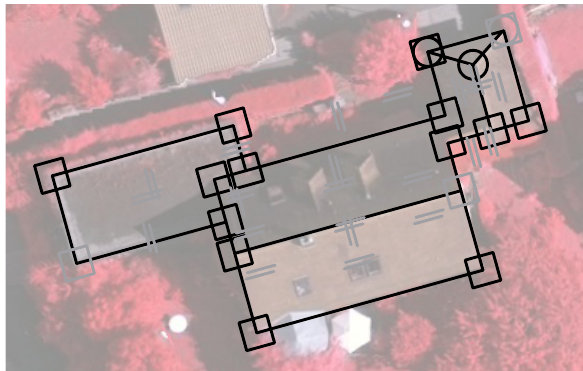
Figure 8. An acquisition of roof areas featuring orthogonality, parallelism, and concurrence. Redundant constraints are marked in gray.